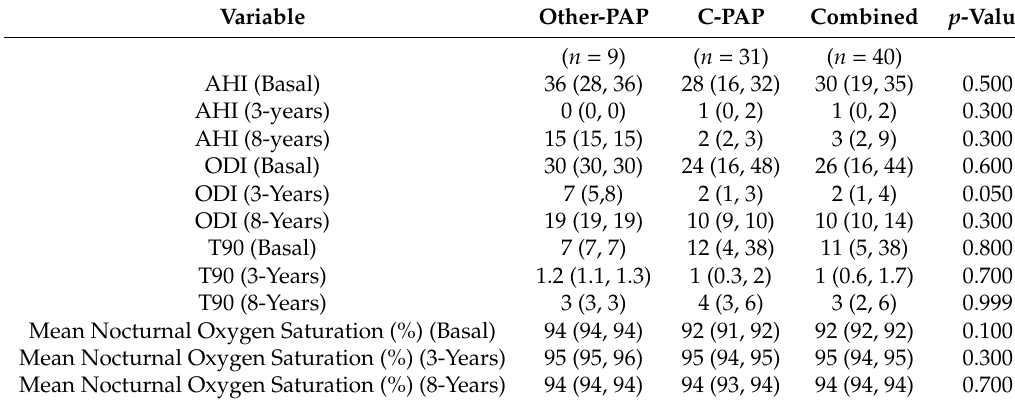
Table 5. Polysomnographic